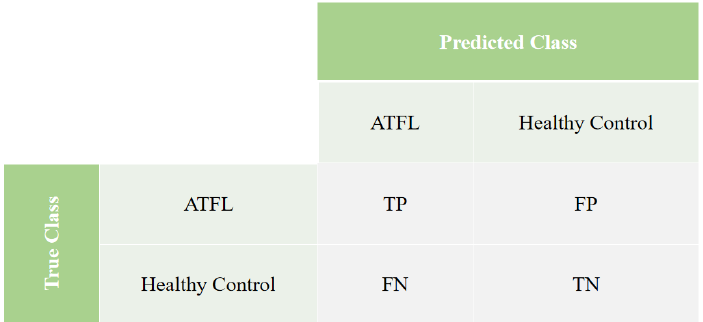
Figure 2. The confusion matrix highlights the validation metrics chosen for experimentation and